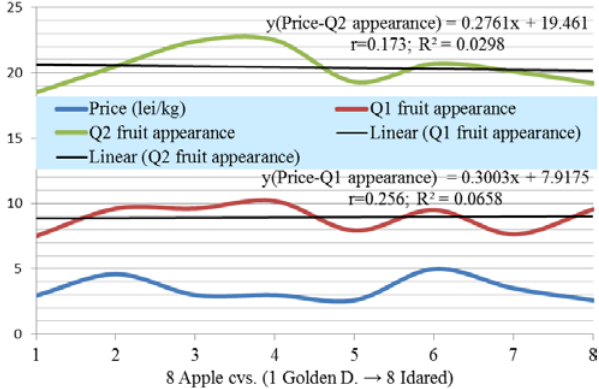
Fig. 8. The correlation coefficients (r), the coefficients of determination (R 2 ) and regression equations (y) within the price and general marks for commercial aspect in Q1 and Q2 The differences based on the marks given by male and female tasters are given in Fig. 9. For this, it was considered only Questionnaire 1, as it was more appreciated by the majority of students.